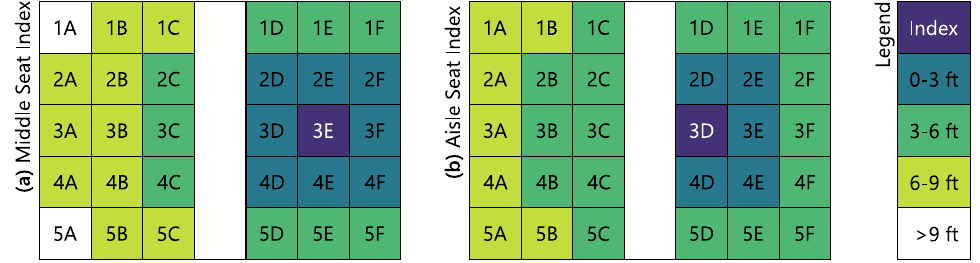
Figure 5. Seat chart for the 5-row cabin section used in the model, colored by distance of susceptible passengers from an index passenger seated in either ( a ) the middle or ( b ) the aisle